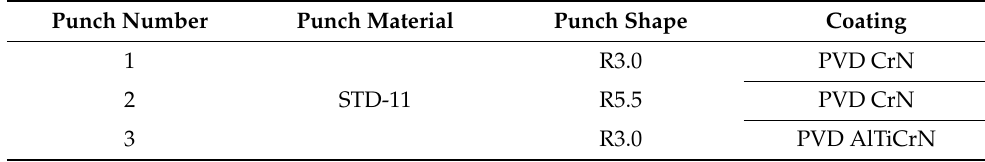
Table 4. Summary of stamping punch conditions for the wear